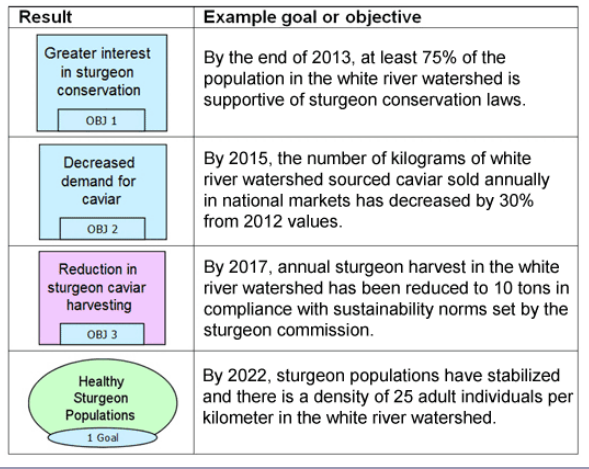
Fig. 7 . Examples of goals and objectives for sample results